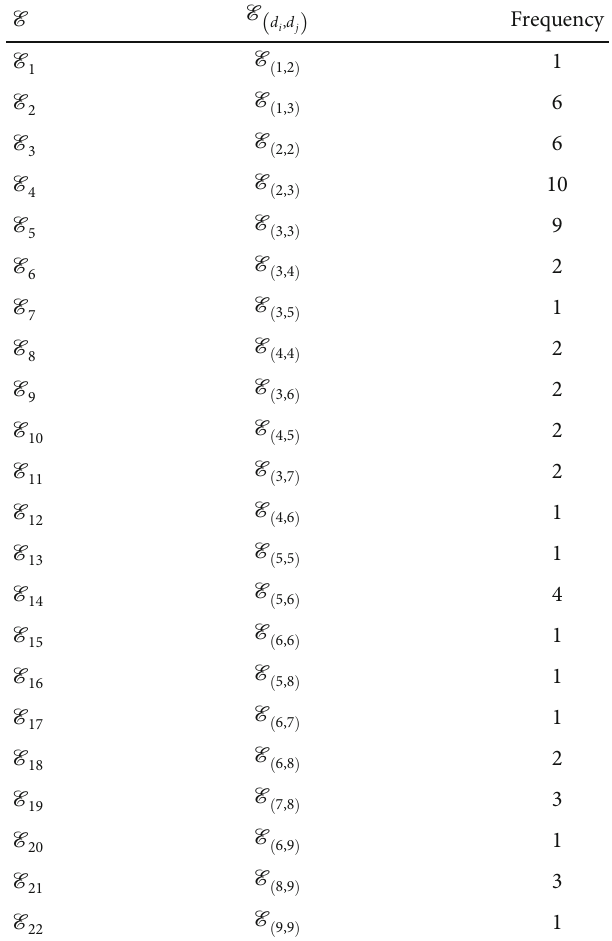
ffiffiffiffiffiffiffiffiffiffiffiffiffiffiffiffiffiffiffiffi ffiffiffiffiffiffiffiffiffiffiffiffiffiffiffiffiffi d + d − 2 1 + 2 − 2 i j ffiffiffiffiffiffiffiffiffiffiffiffiffiffiffiffiffi ffiffiffiffiffiffiffiffiffiffiffiffiffiffiffiffiffi 2 + 2 − 2 2 + 3 − 2 ffiffiffiffiffiffiffiffiffiffiffiffiffiffiffiffiffi ffiffiffiffiffiffiffiffiffiffiffiffiffiffiffiffiffi 3 + 4 − 2 3 + 5 − 2 ffiffiffiffiffiffiffiffiffiffiffiffiffiffiffiffiffi ffiffiffiffiffiffiffiffiffiffiffiffiffiffiffiffiffi 3 + 6 − 2 4 + 5 − 2 ffiffiffiffiffiffiffiffiffiffiffiffiffiffiffiffiffi ffiffiffiffiffiffiffiffiffiffiffiffiffiffiffiffiffi 4 + 6 − 2 5 + 5 − 2 ffiffiffiffiffiffiffiffiffiffiffiffiffiffiffiffiffi ffiffiffiffiffiffiffiffiffiffiffiffiffiffiffiffiffi 6 + 6 − 2 5 + 8 − 2 ffiffiffiffiffiffiffiffiffiffiffiffiffiffiffiffiffi 6 + 8 − 2